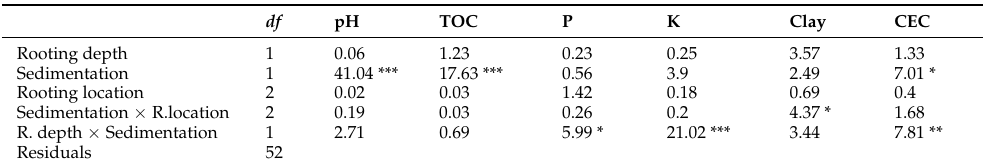
Table 5. Univariate test statistics of the effects of rooting depth type, sedimentation, and rooting location on soil NIR data. df